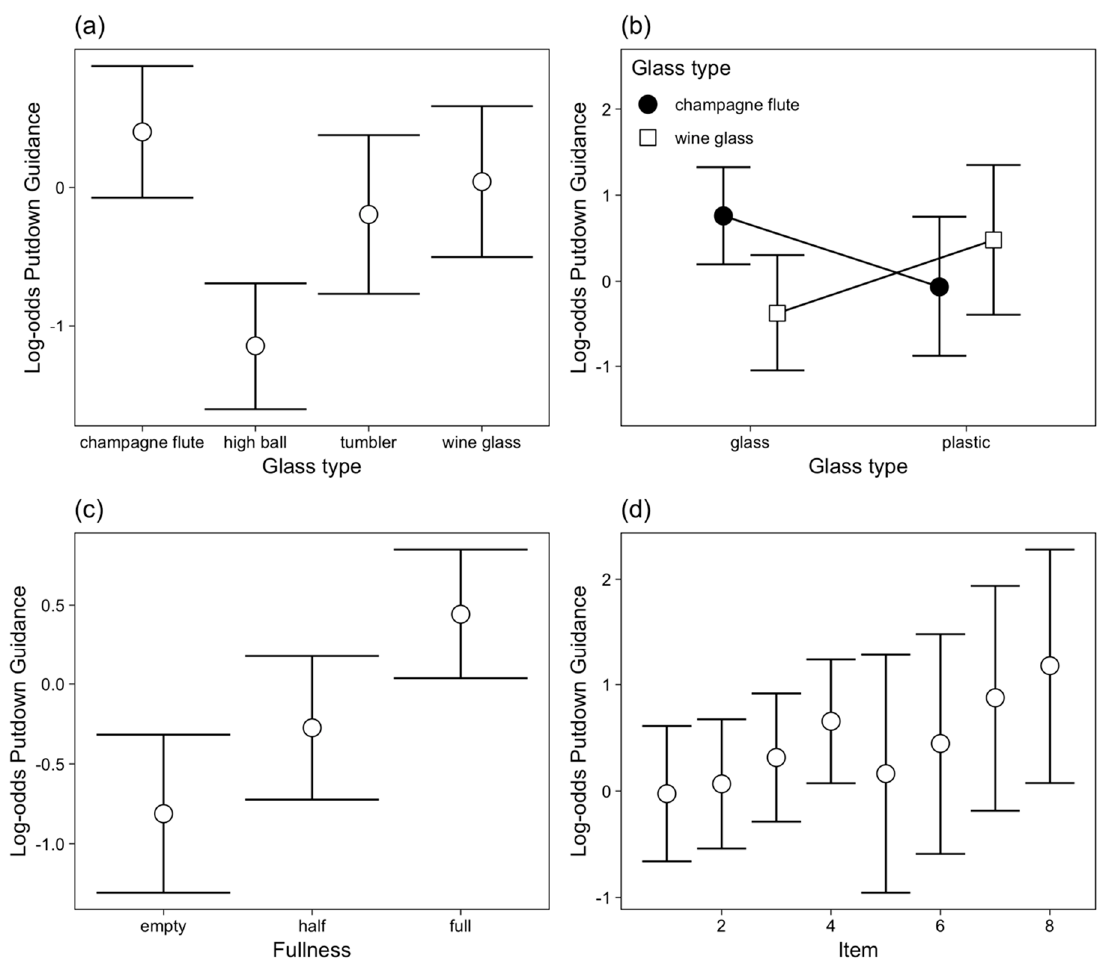
Figure 6. Log-odds of fully-guided (vs partially-guided) putdowns (for putdown 2) across participants to illustrate the effects of ( a ) glass type, ( b ) the interaction between glass type and material, ( c ) fill level and ( d ) glass (putdown) number with 95% CI. Individual plots for each participant are shown in Appendix Figure A4.